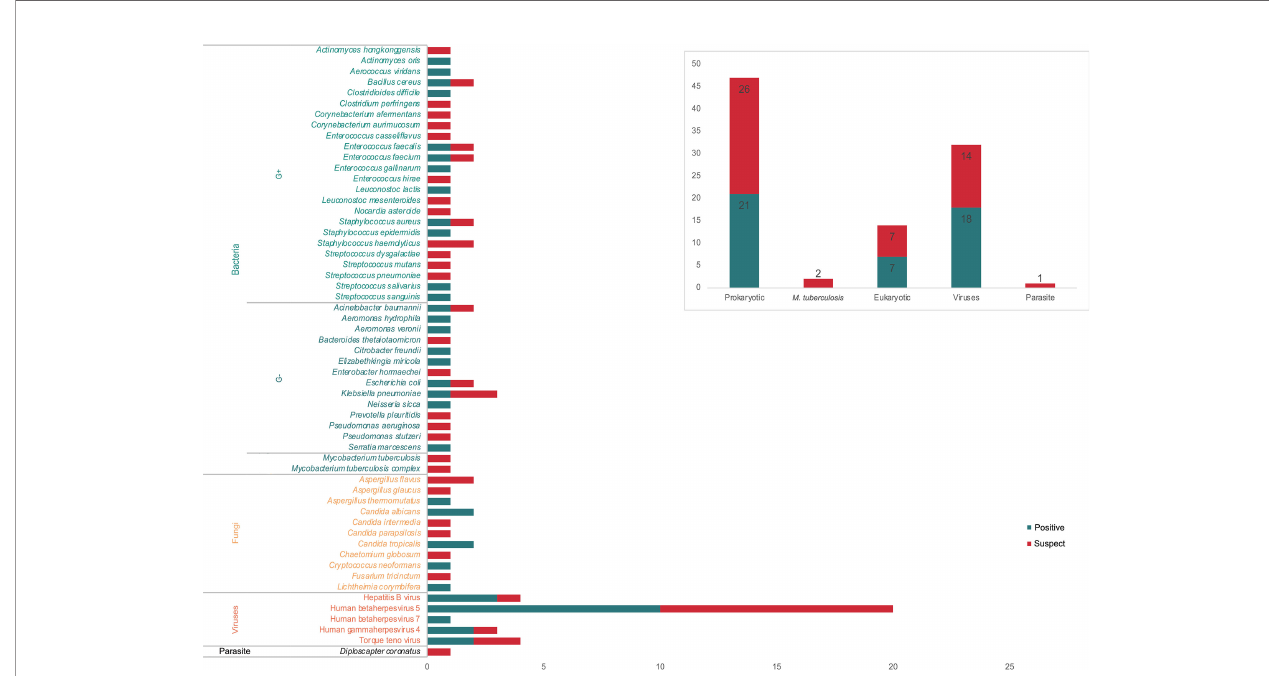
FIGURE 3 | The positive and suspected pathogens detected by metagenomic next-generation sequencing (mNGS). A total of 96 pathogens were detected, including 47 bacteria, 32 viruses, 14 fungi, 2 M. tuberculosis , and 1 parasite, of which 46 were considered as positive.